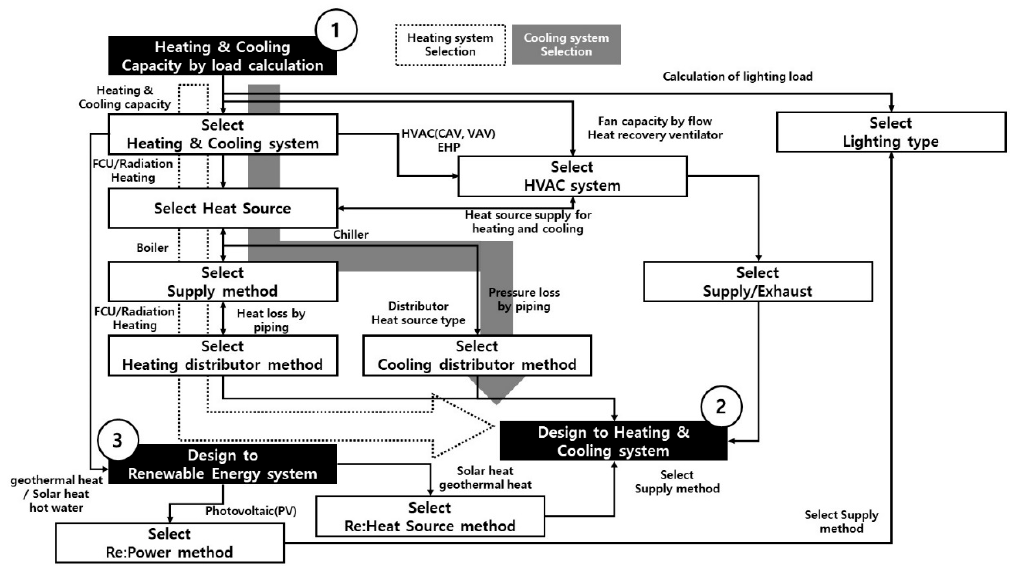
Figure 4. Process of the active technical package.